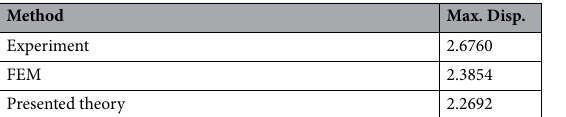
Table 4. The maximum vertical dimensionless displacement, W , for a simply supported sandwich plate with an auxetic core under a uniform compressive loading.